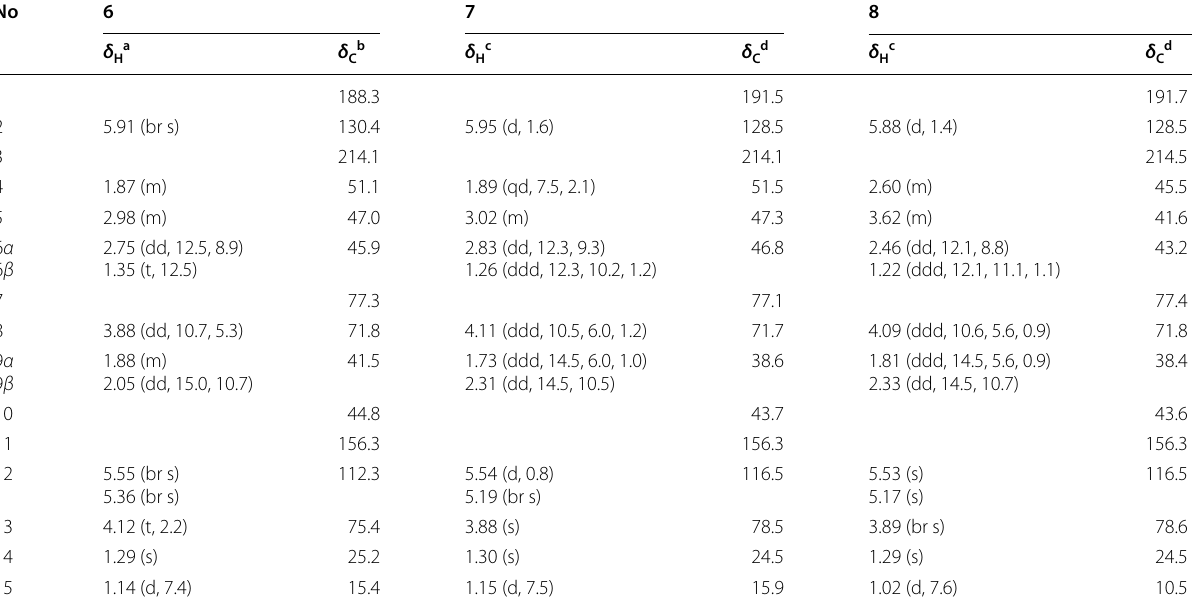
( δ in ppm, J in 4